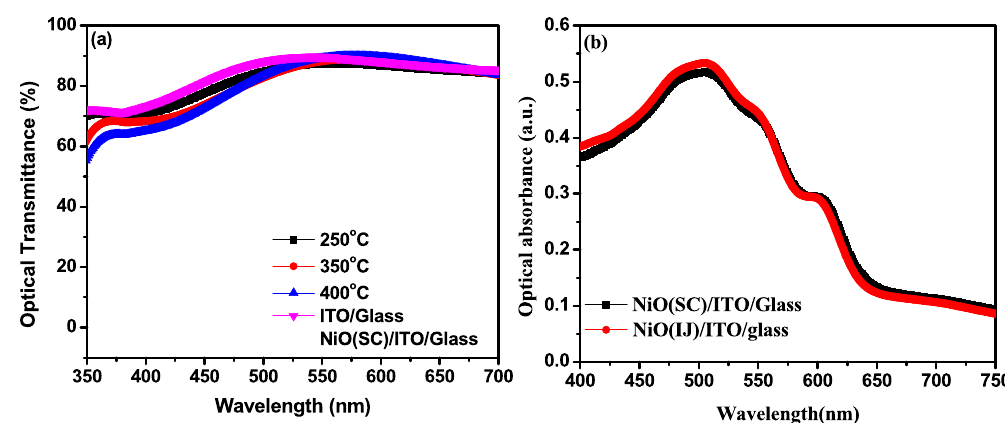
Figure 6. ( a ) Transmission spectra of printed NiO films and spin coated NiO films (as reference) and ( b ) UV- Vis absorbance spectra of 70 nm thin P3HT:PC 60 BM films on printed NiO and spin coated NiO films on ITO/ Glass